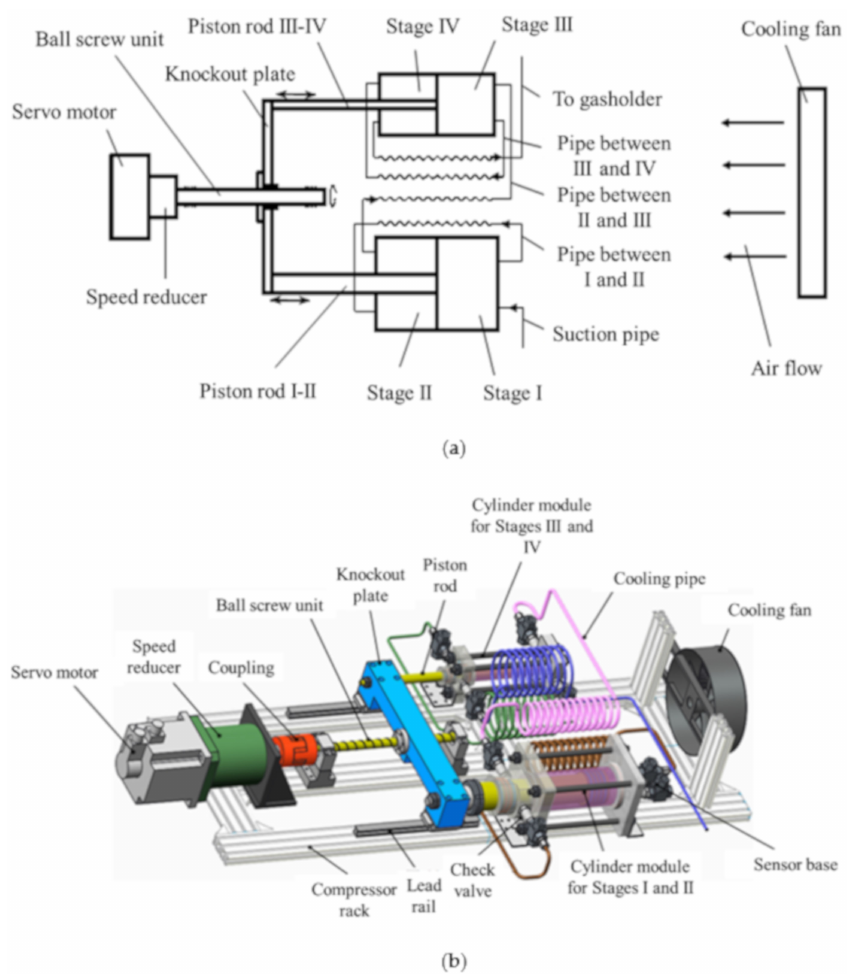
Figure 1. ( a ) Structural diagram and ( b ) 3D model of the multistage compressor